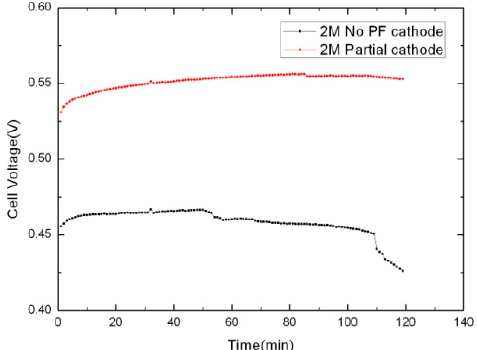
Figure 7. Power density of the μ -DMFCs with no PF cathode, full PF cathode, and partial PF cathode: ( a ) 2 M and ( b ) 4 M methanol solutions.